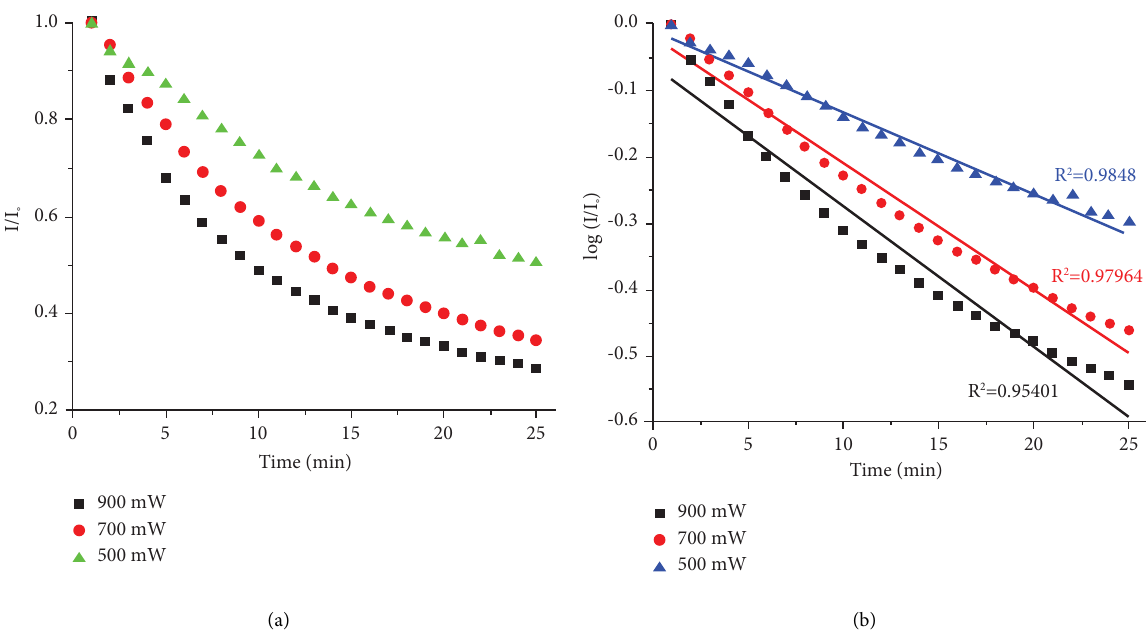
Figure 3: (a) Relative Raman intensity at 1838cm − 1 (attributed only to fuorescence) of a 40mg · ml -1 BSA solution with diferent nominal laser powers as a function of time with 532nm excitation in the ChiralRAMAN-2X ™ without recirculation. (b) I/I 0 of 900, 700, and 500mW photobleaching curves in log scale with trendlines overlaid.